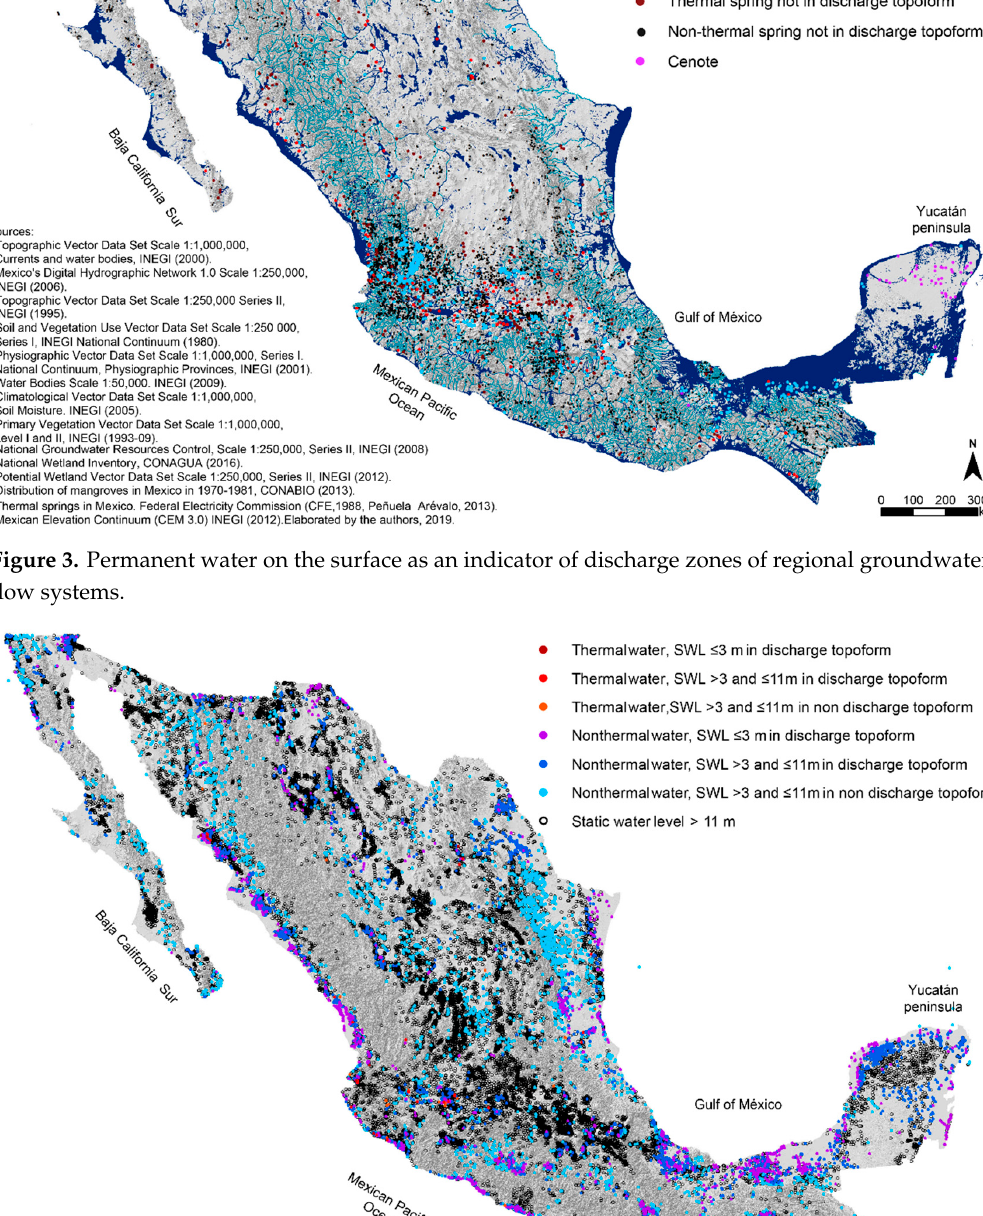
Figure 4. Groundwater depth.